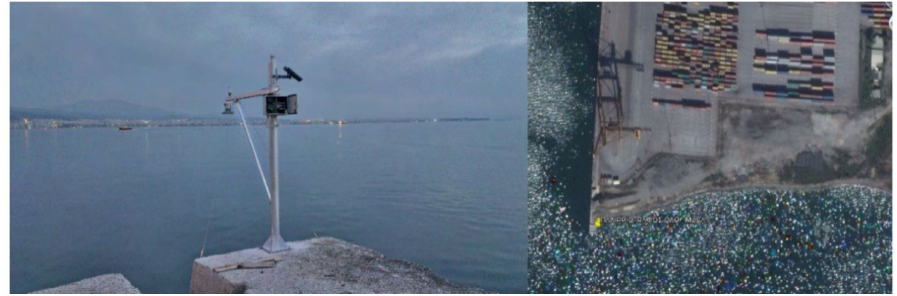
Figure 9. Installed tide gauge ( left ) in the commercial port of Thessaloniki (Pier 6, right